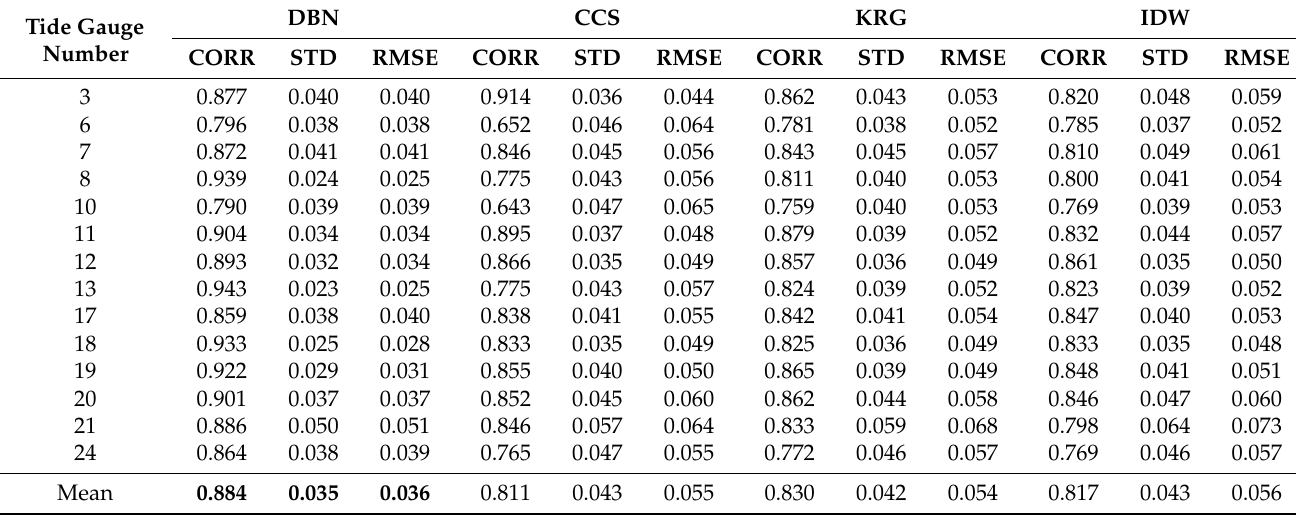
Figure 5. The distribution of altimetry-derived SLAs in the training data (blue dots) and the in-situ tide gauge training data (blue triangles) as well as validation data (red dots) in schemes (a) and (b) . Table 1. Statistics of the four methods with altimetry-derived gridded SLAs in schemes (a)